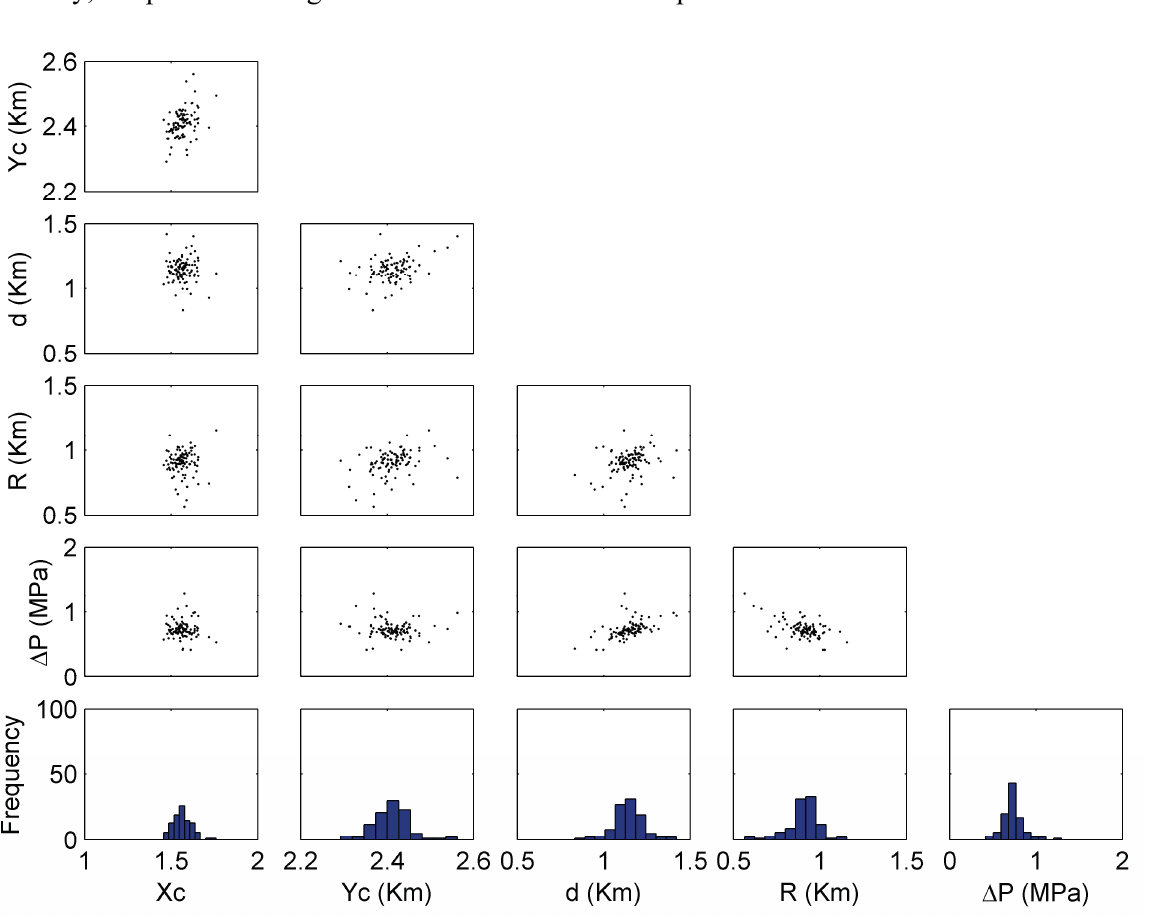
Figure 8. Matrix plot for 100 groups of best fit poroelastic disk reservoir parameters for InSAR derived displacement with mean phase value as reference and with added noise in Gudao Town (oilfield). A well confined parameter shows symmetric distribution in histogram or dots plot. A wide scatter means the parameter is